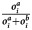
Experimental investigation of the size invariance of oiaoia+oib.A: asymmetric purification of O1 assemblies. The blue and red lines indicate purified portions of O1 peak corresponding to large and small assemblies, respectively. The depolymerisation of large O1 assemblies (in blue) and small O1 assemblies (in red) has been monitored at 0.3μM
(B) and 6μM
(C) and reveals an isokinetic behaviour between large and small O1 assemblies. This isokinetic behaviour suggests a kinetic parameter invariance all along the size distribution landscape and sheds light on the molecular basis of O1 architecture.